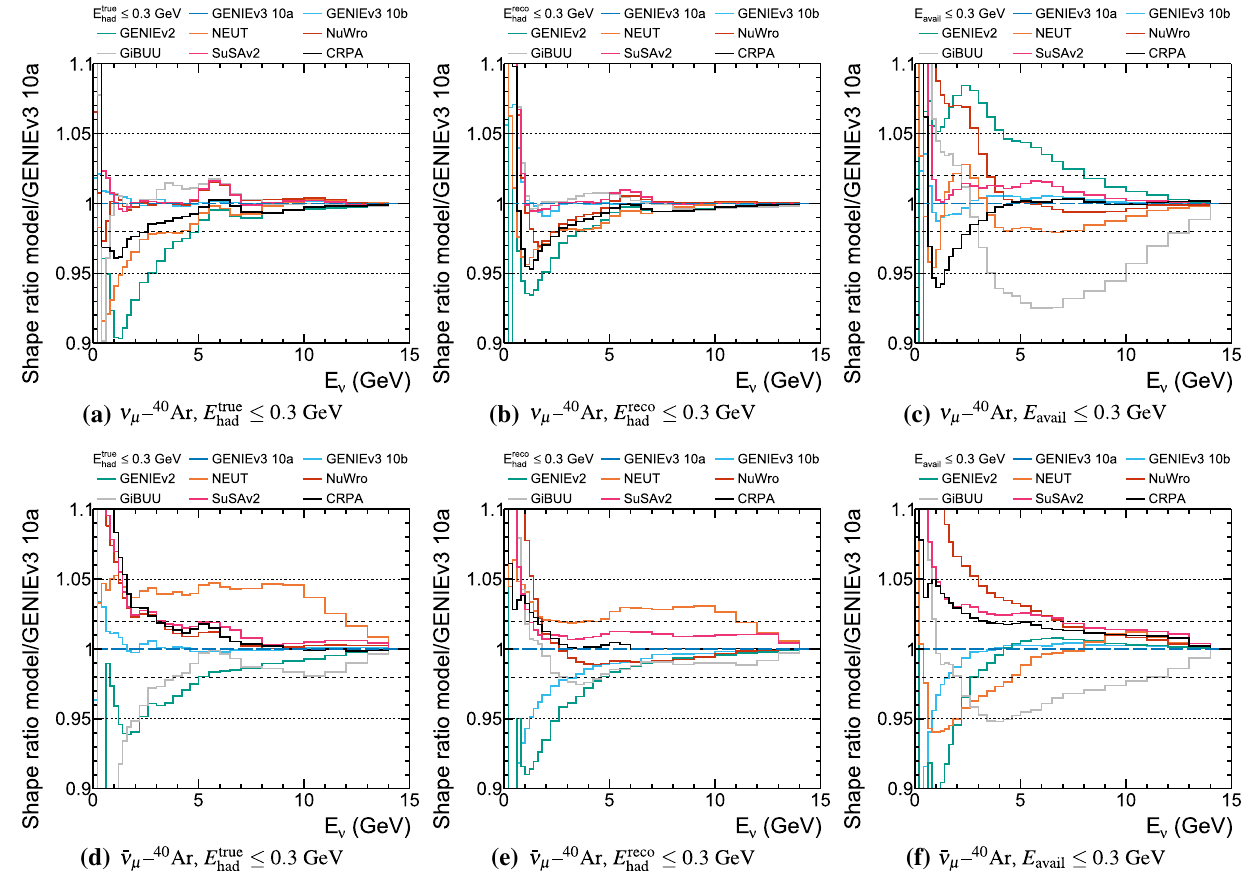
Fig. 9 Comparisonoftheshape-onlyratios(withrespecttotheGENIE 10a prediction) of the ν μ – 40 Ar and ¯ ν μ – 40 Ar charged-current cross sec- tions with a cut on 0.3 GeV for the three proxy variables, E true and E avail , as a function of E true ν . Figures produced using the flat neu-